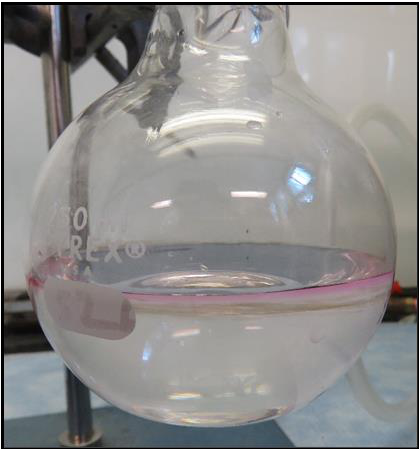
Figure 2. NH 3(g) (3.3% v/v) headspace and aqueous solution with phenolphthalein indicator dye (0.001%) after 2 min. Phenolphthalein indicator dye is colorless <pH 8.2 and pink/red >pH 8.2.